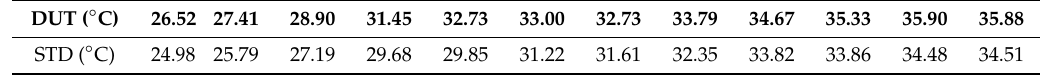
Table 2. Calibration mappings for a humidity sensor in the Bao